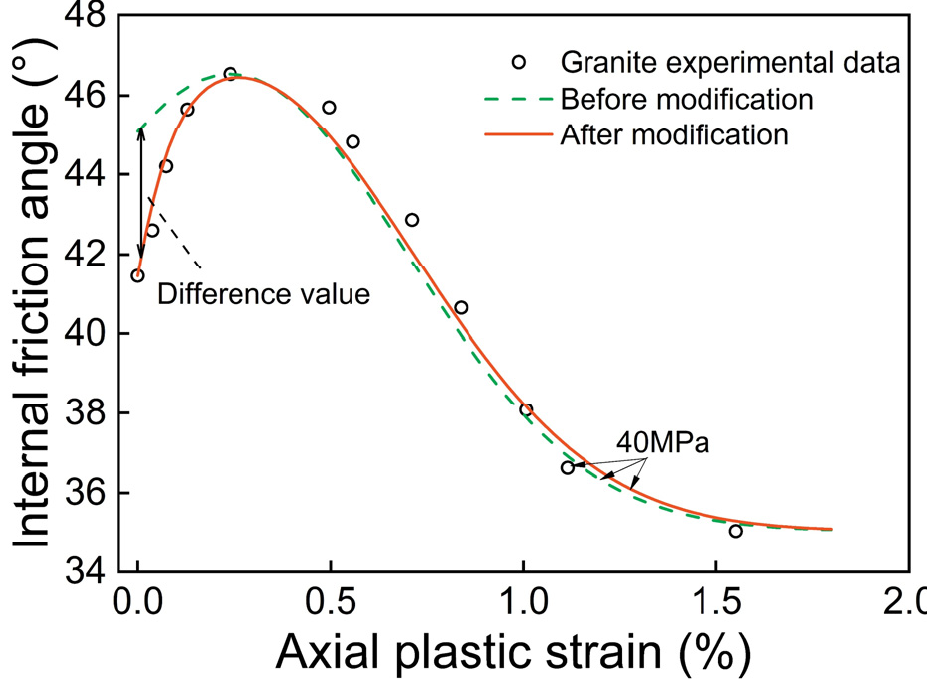
Figure 5. The fitting results of the Gaussian function before and after modification (the internal friction angle of Beishan granite [26] under 40 MPa).